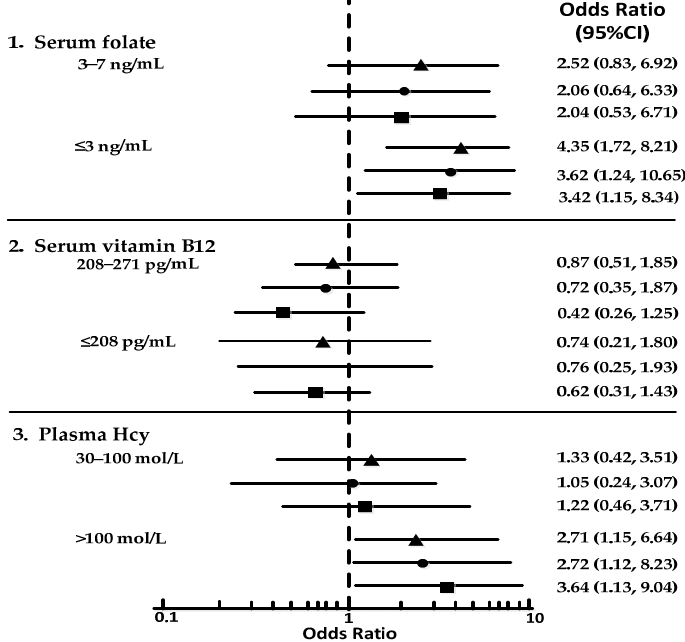
Figure 4. Forest plots showing ORs for tertiles of the vitamin and Hcy levels in AD. 1 indicates comparing to tertile of >7 ng/mL; 2 indicates comparing to tertile of >271 pg/mL; 3 indicates comparing to tertile of ≤ 30 mol/L. This figure illustrates unadjusted model （ ▲ ）， adjusted model for age, sex, and education （ ● ） ; and adjusted model for age, sex, education, folate, vitamin B 12 , and Hcy （ ■ ） .